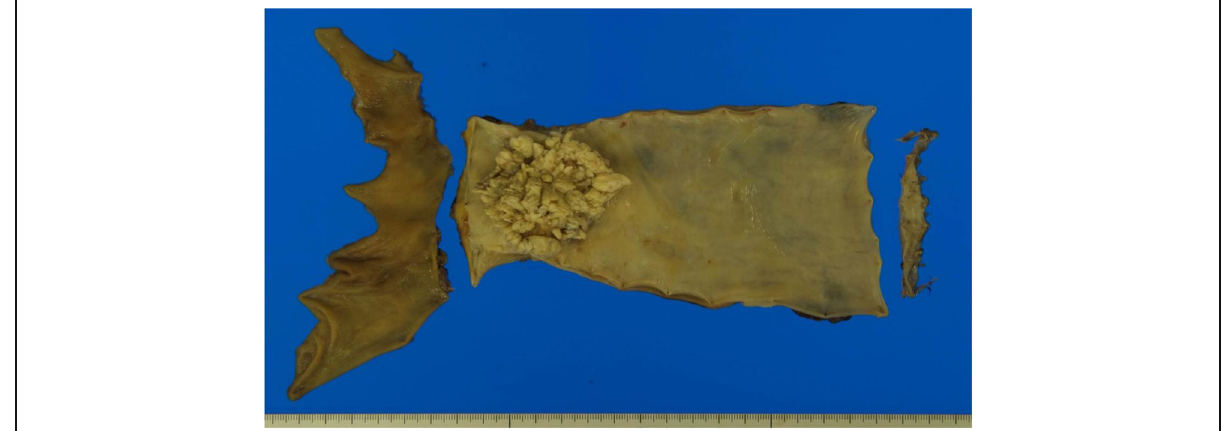
Fig. 6 Macroscopic findings of the resected specimen. White protruding lesion with an irregular surface was seen at the lower